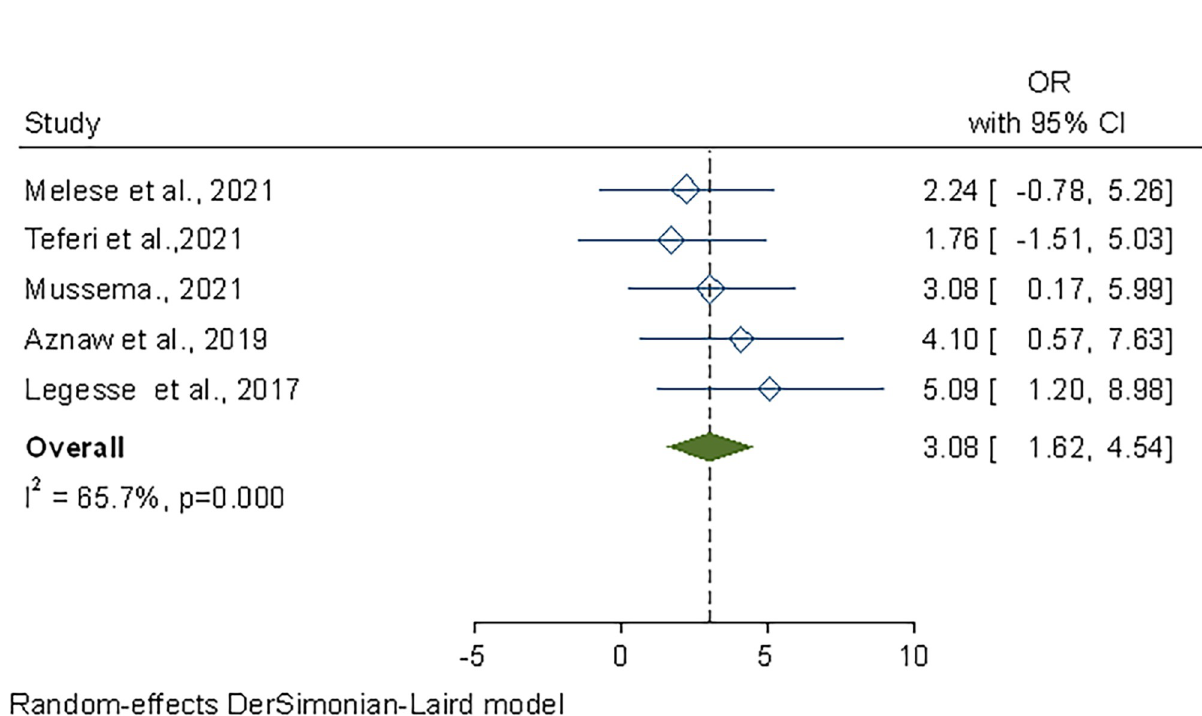
Fig 9. Forest plot of the association between sanitary inspection and safe food handling practice in Ethiopia, 2022.